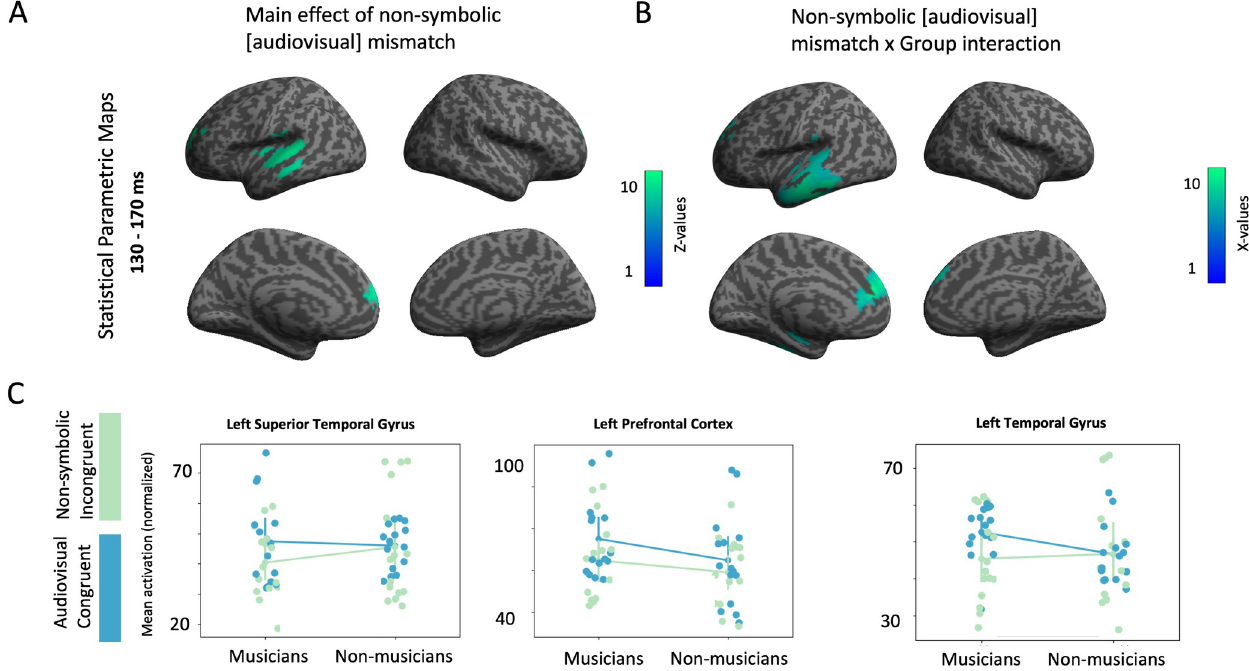
Fig 4. Audiovisual non-symbolic mismatch response generators in musicians and non-musicians. A: Statistical Parametric Maps for the main effect of audiovisual non-symbolic incongruency. Threshold p < 0.005, cluster corrected. B: Statistical Parametric Maps for the interaction audiovisual non-symbolic mismatch × group. Threshold p < 0.05, cluster corrected. C. Point plots depicting individual’s and mean activity for each statistically significant cluster of activation for the main effect of audiovisual non-symbolic mismatch and audiovisual non-symbolic mismatch × group interaction.